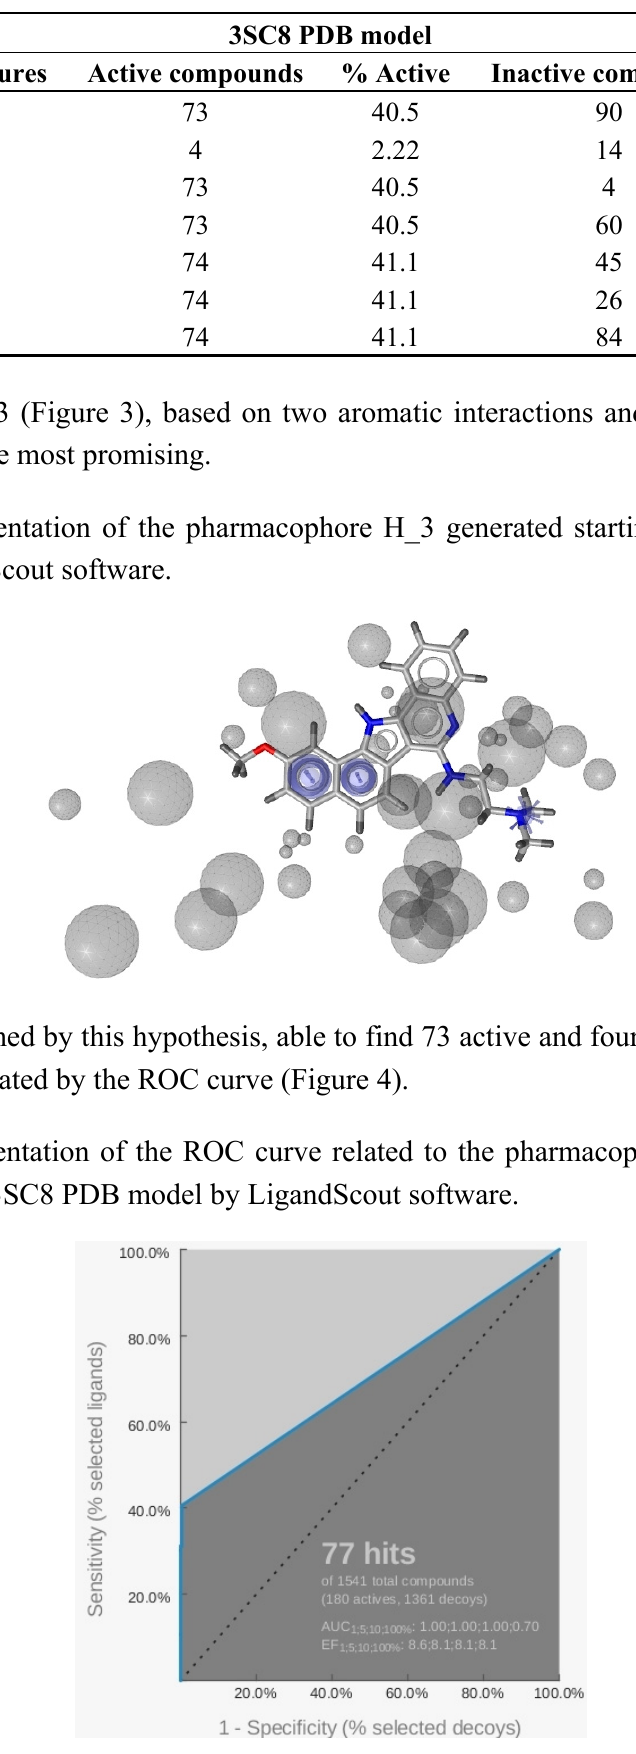
Table 2. Classification of the pharmacophore hypotheses generated by 3SC8 PDB model.